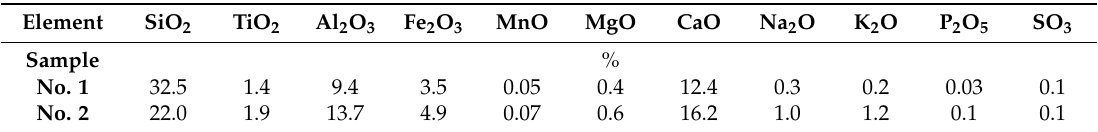
Table 3. Elemental composition of vitrified samples carried out by XRF standardless analysis, values calculated to oxide form (the results have not been normalized to